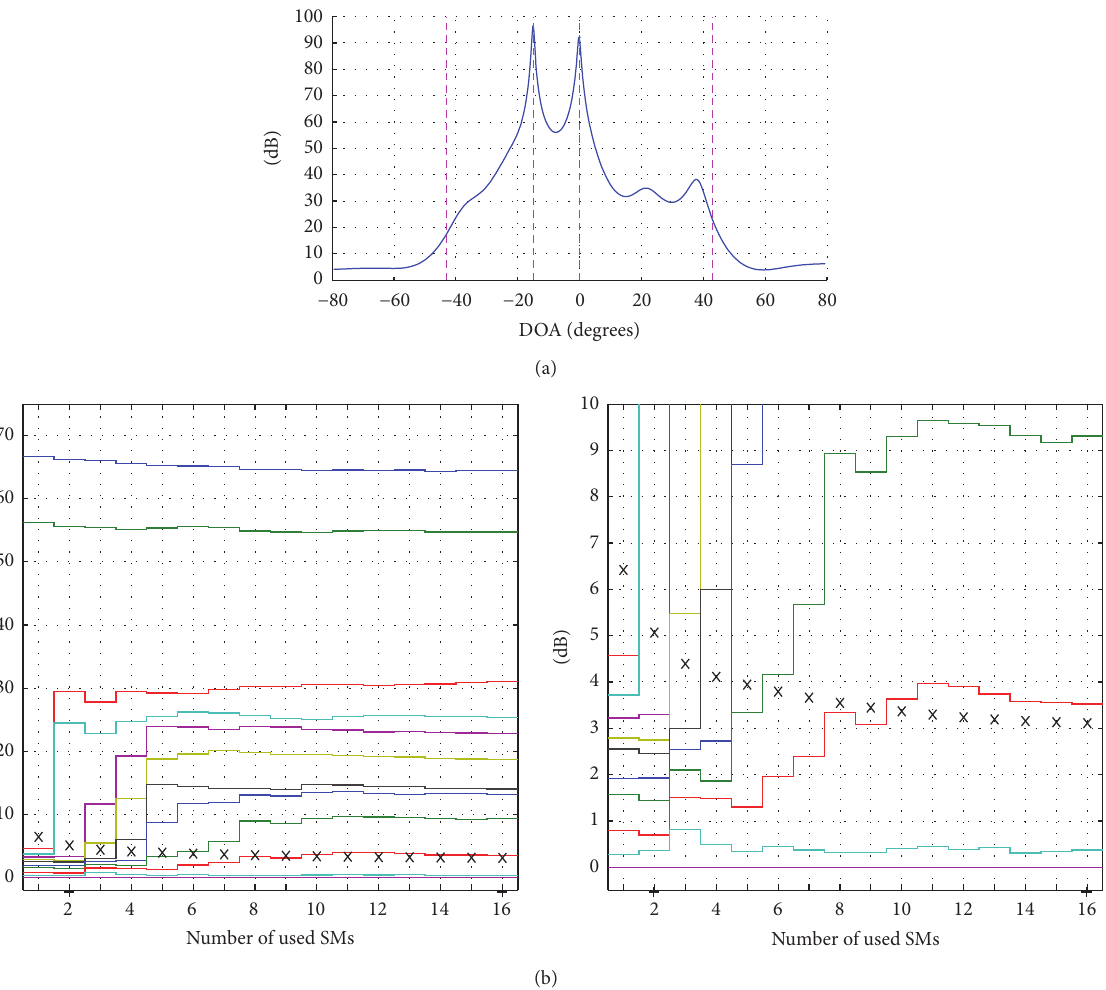
Figure 10: Measurement U2SS. Two uncorrelated strong transmitters. (a) Capon DOA spectrum. (b) Eigenspectrum. Zoom-in to the right. dB scale. See Section 3.3 for